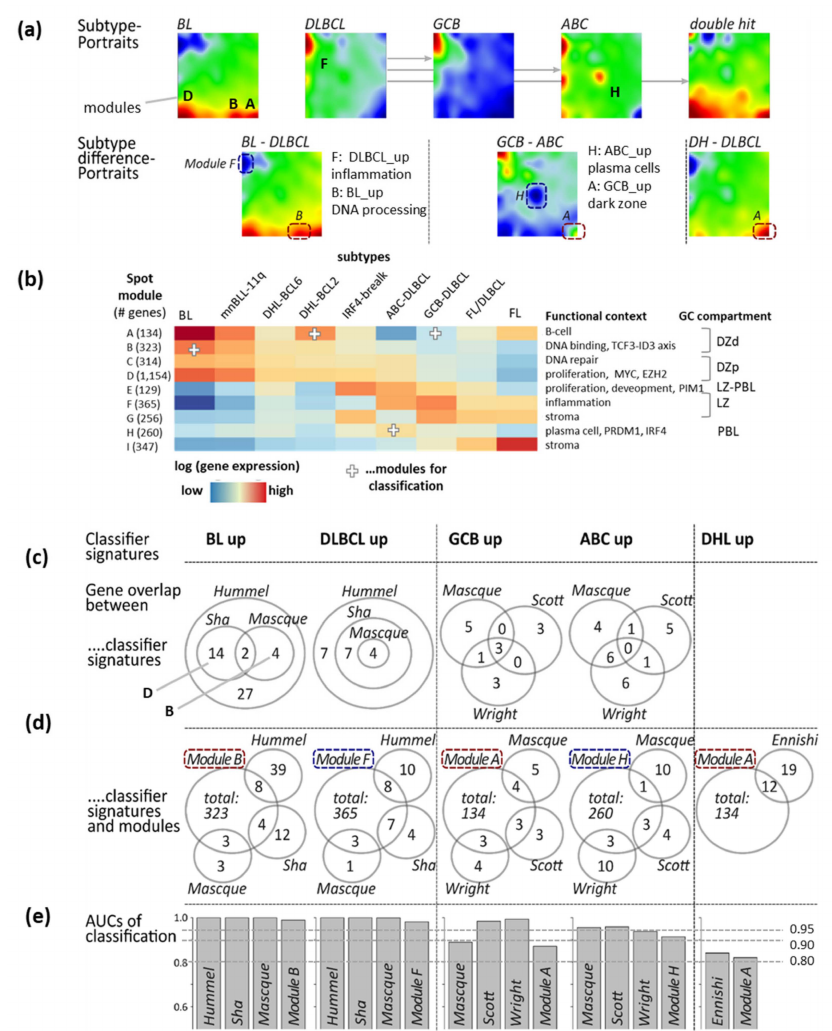
Figure 5. SOM portrayal and subtype classifiers of B-cell lymphomas: ( a ) SOM portraits of selected B-cell lymphoma subtypes (BL, DLBCL, ABC-, GCB- DLBCL and DHL) show specific expression patterns characterized by “spot” modules of overexpressed genes (red spots, labeled by capital letters in agreement with [4]). Difference portraits reveal differentially expressed genes in red (up) or blue (down). ( b ) The heatmap provides an overview of spot expression in the different subtypes together with major functional context and assignment to compartments of the GC reaction. White crosses indicate spots used for classifiers in this publication. Full lists of spot genes are provided in the Supplementary Material of [4]. ( c ) Different classifier gene sets for two-group comparisons (BL- vs-DLBCL, ABC-vs-GCB, DHL-vs-nonDHL) taken from literature often only moderately mutually overlap due to selection uncertainty and function bias of the test data used for classifier “building” (Table 2). The confusion table of jointly detected samples by applying the different classifiers is provided in Figure A7. ( d ) Overlap of literature classifiers with spot modules. ( e ) Literature classifiers almost similarly perform in terms of area under (ROC) curve (AUC) values. Although spot modules were not specially designed for classifying tasks, they provide almost similar results for discriminating